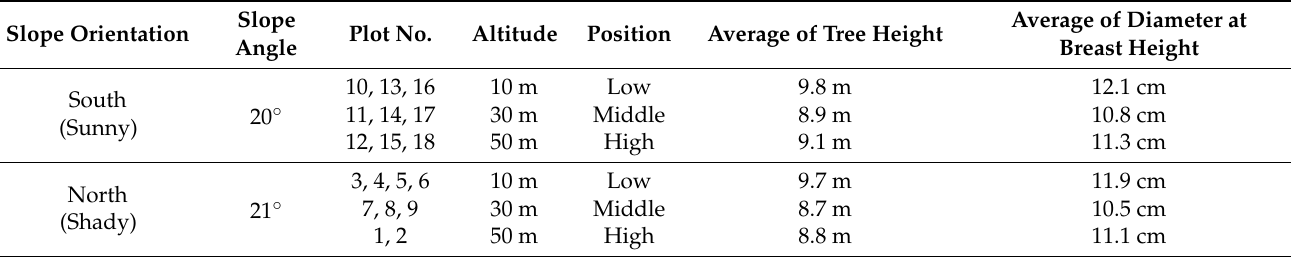
Table 1. The position and tree information for each plot.